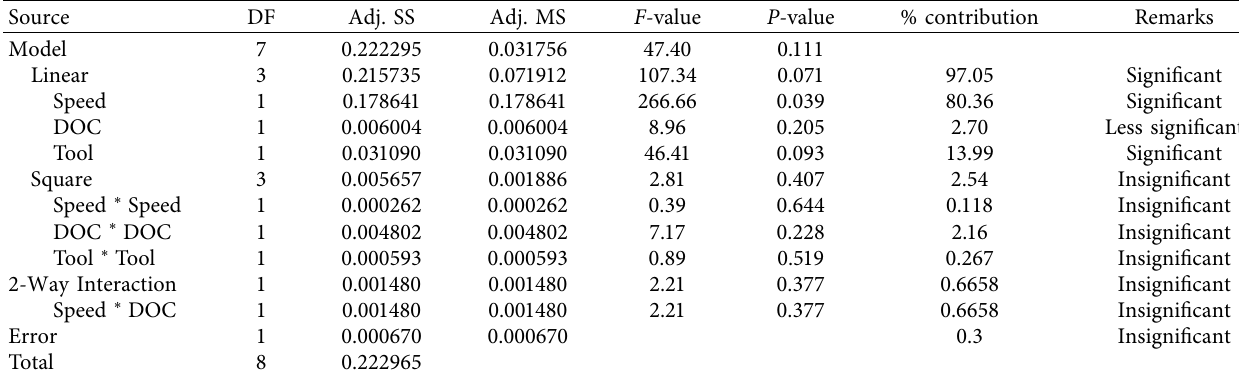
Table 18: ANOVA to investigate the input factor contribution for milling AA 2014.